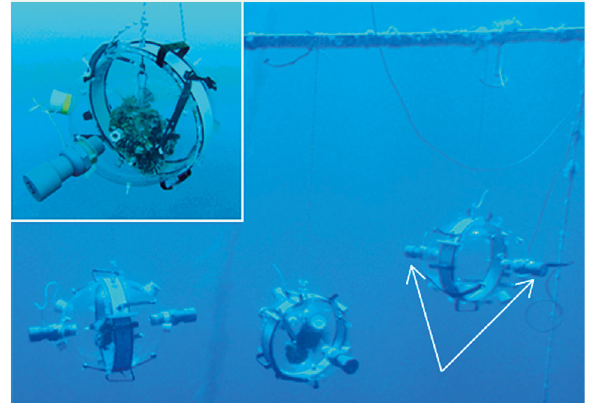
Fig. 2. In situ metabolic enclosure system (MES) used for flux measurements. Magnetic stirrers (arrows) were used on each side of the MES to gently homogenize the